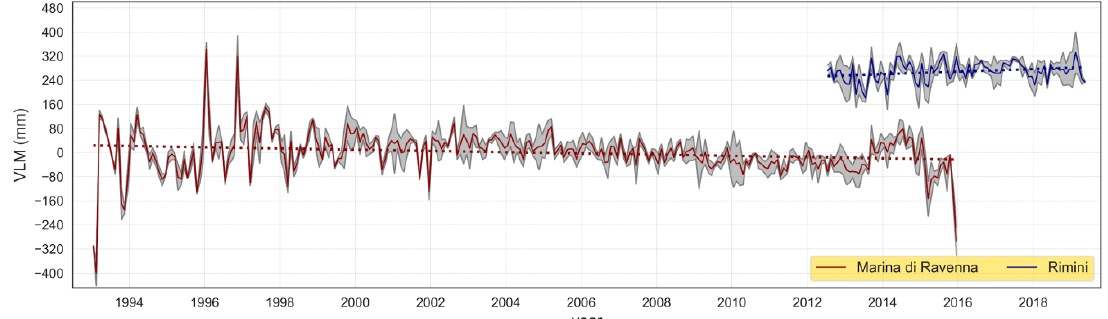
Figure 8. Time series of the N − S = U term at Marina di Ravenna (red) and Rimini (blue) computed by using Equation (1). Gray area represents data error range. The time series are shifted in the vertical scale for presentation purposes.